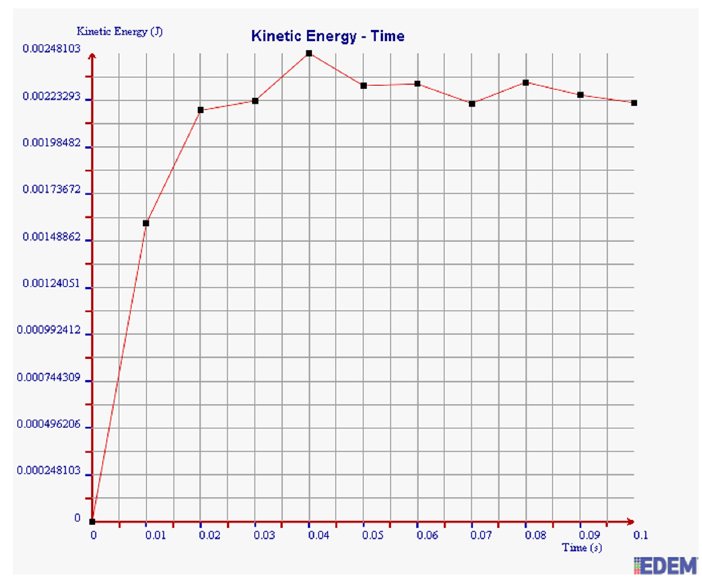
Figure. 19 Kinetic energy of 3 mm steel balls. Figure 19. Kinetic energy of 3 mm steel balls.